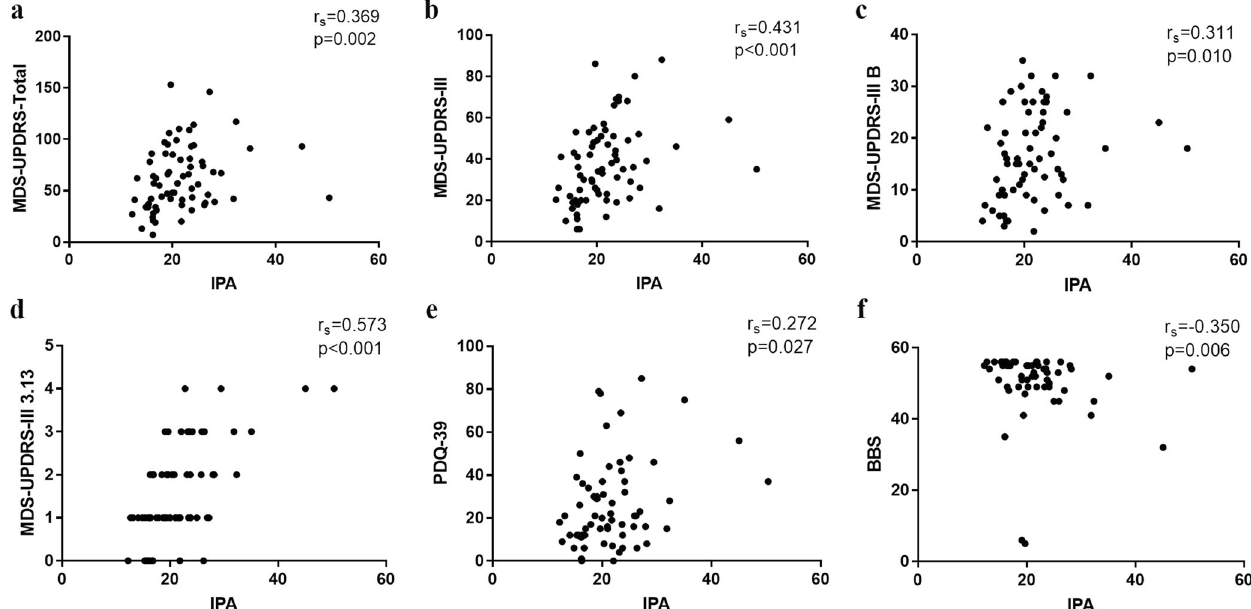
Fig. 3 The correlations between clinical measurements and IPA. Spearman ’ s correlation analysis revealed signi fi cant correlations between MDS-UPDRS-Total, MDS-UPDRS-III, MDS-UPDRS-III B, MDS-UPDRS-III 3,13, PDQ-39 and BBS scores and IPA in all PD patients ( a – f ). IPA the index for postural abnormalities, MDS-UPDRS the Movement Disorder Society-Sponsored Revision of the Uni fi ed Parkinson ’ s Disease Rating Scale, PDQ-39 the 39-item Parkinson ’ s Disease Questionnaire, BBS the Berg Balance Scale.